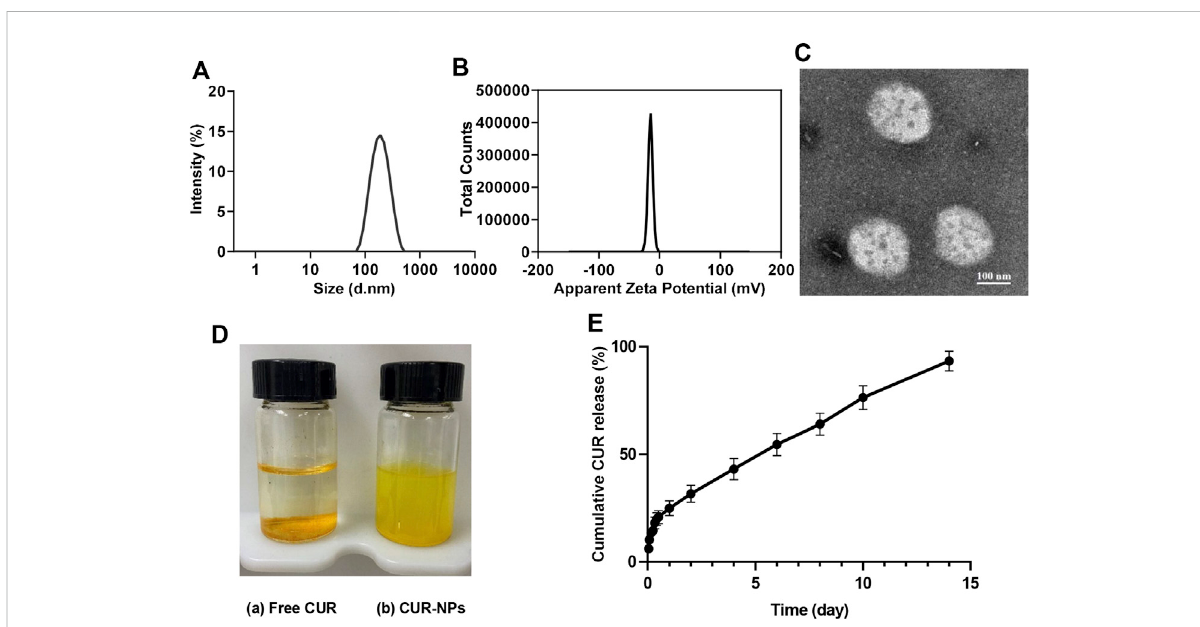
FIGURE 7 CharacterizationofCUR-NPs. (A) ThehydrodynamicdiameterofCUR-NPs. (B) ThezetapotentialofCUR-NPs. (C) TheTMEimageofCUR-NPs. (D) The appearances of free CUR(a) and CUR-NPs(b) dissolved in ultrapure water. (E) In vitro CUR release from